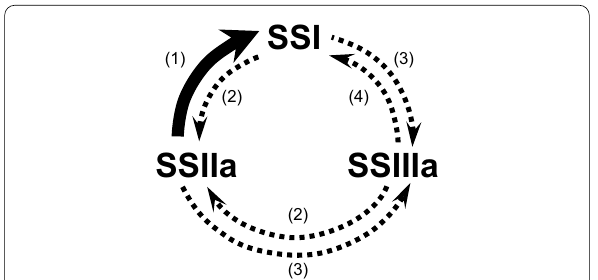
Fig. 3 Summary of the relationships between three starch synthase (SS) isozymes in the rice endosperm. (1) Active SSIIa compensates for most of the function of SSI, particularly elongating amylopectin chains from the degree of polymerization (DP) of 6–7 to DP 8–12 (thick arrow). (2) The function of SSIIa could not be complemented by SSI or SSIIIa (dotted arrows). (3) Neither SSI nor SSIIa could compensate for the function of SSIIIa, which synthesizes amylopectin chains with DP > 35 (dotted arrows). (4) The function of SSI could not be complemented by SSIIIa (dotted arrow). This figure was obtained from Crofts et al.